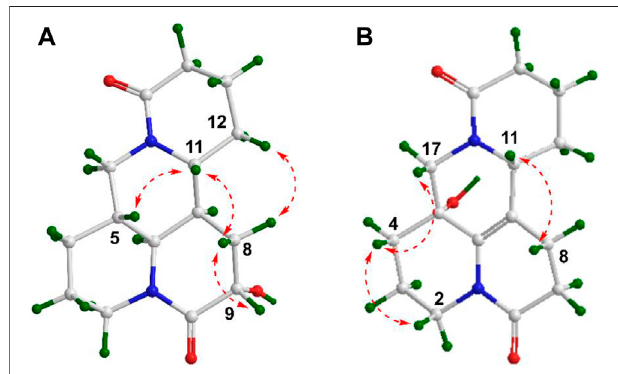
FIGURE 4 | Key NOESY correlations of 2 (A) and 4 (B) .